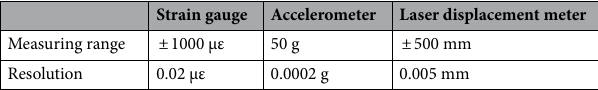
Table 5. Performance parameters of all sensors.